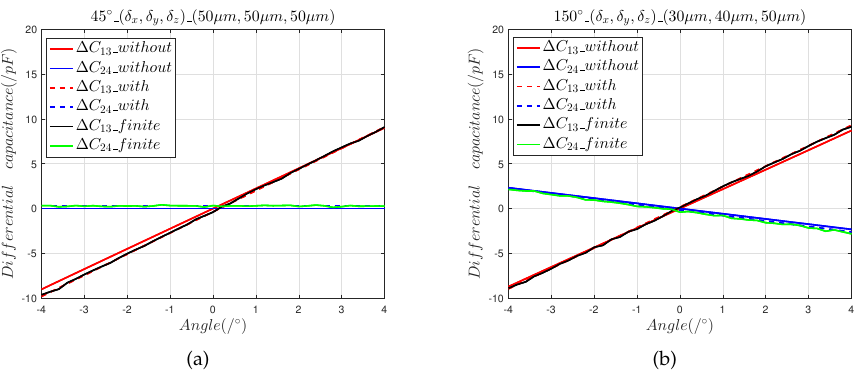
Figure 10. The (30 µ m, 40 µ m, and 50 µ m) composite installation errors analysis: ( a ) differential capacitance in direction 45 ◦ ; ( b ) differential capacitance in direction 150 ◦ .